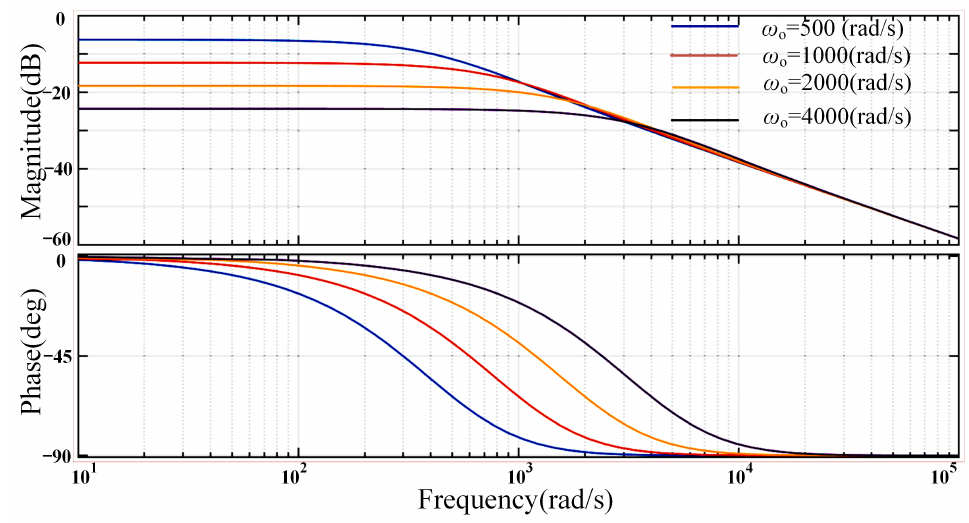
Figure 4. Bode diagram of the transfer function G i 1_ u